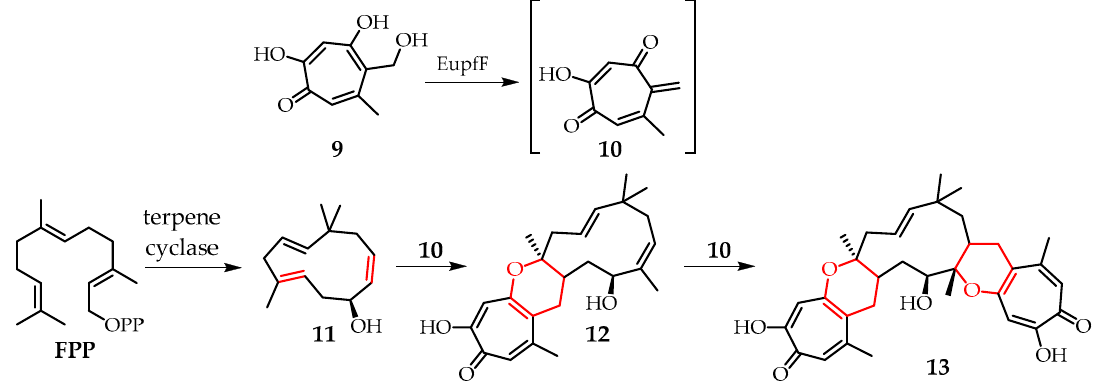
Figure 4. Biosynthetic way for the production of neosetofomon B ( 12 ) and upenifeldin ( 13 ).